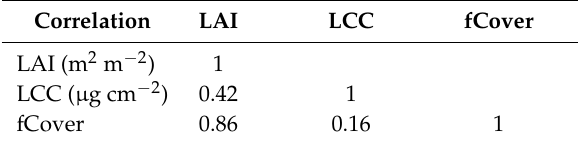
Table 3. The correlation coefficient between variables measured in the fields (n = 27).